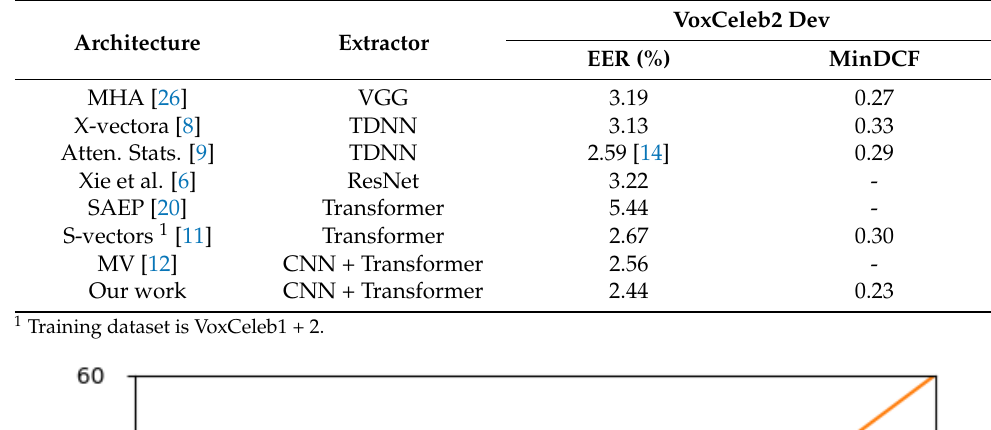
Table 1. Performance comparison with the VoxCeleb1 test set.